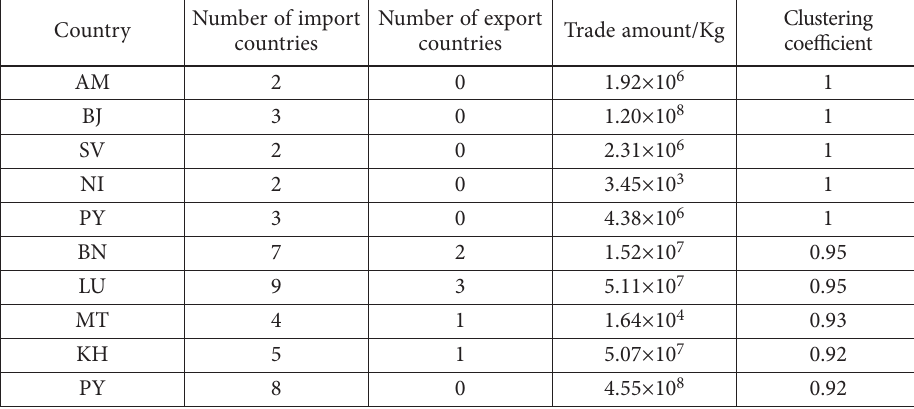
Clustering coefficient